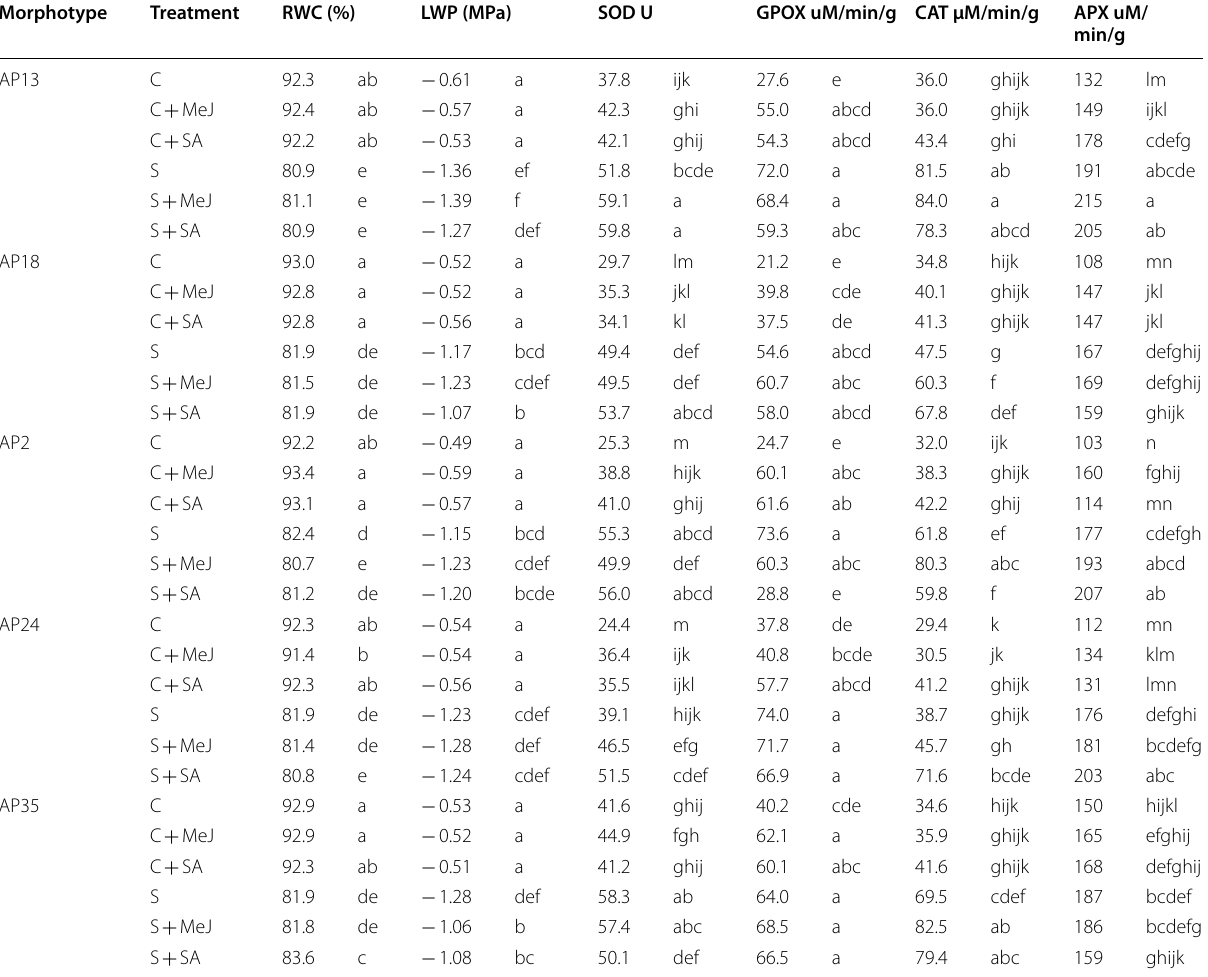
Table 2 Relative leaf water content, leaf water potential and activity of antioxidant enzymes in leaves of Andrographis paniculata at 140 DAT